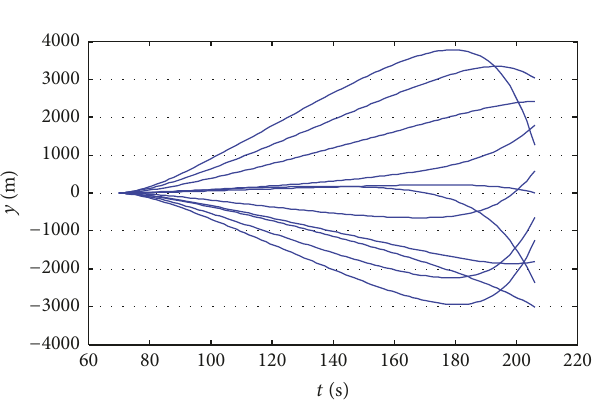
Figure 7: Altitude modifications with different